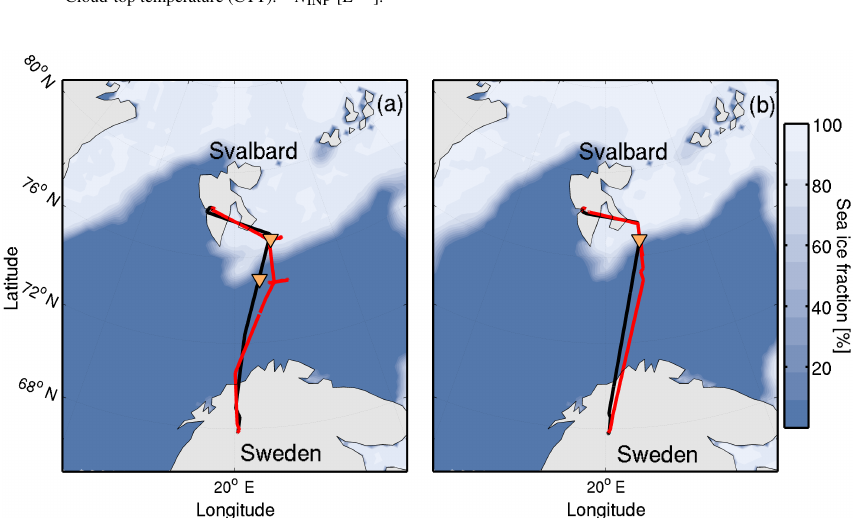
Figure 2. Flight track of (a) B762 and (b) B764, with section 1 (black) and section 2 (red) indicated. Dropsondes were released during section 1, whilst in situ observations were made during section 2. Dropsonde release locations are marked (orange triangles). (a) Case 1 (sea ice, north) and case 3 (ocean, south) are from flight B762, (b) case 2 (MIZ) is from B764. Sea ice fraction is shown in